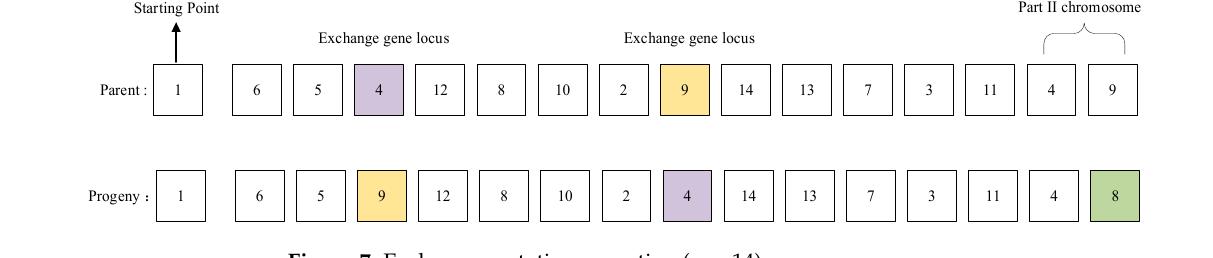
Figure 7. Exchange mutation operation ( m = 14). The insertion mutation randomly selects a gene or part of a gene in a chromosome to insert into a random site, as shown in Figure 8.